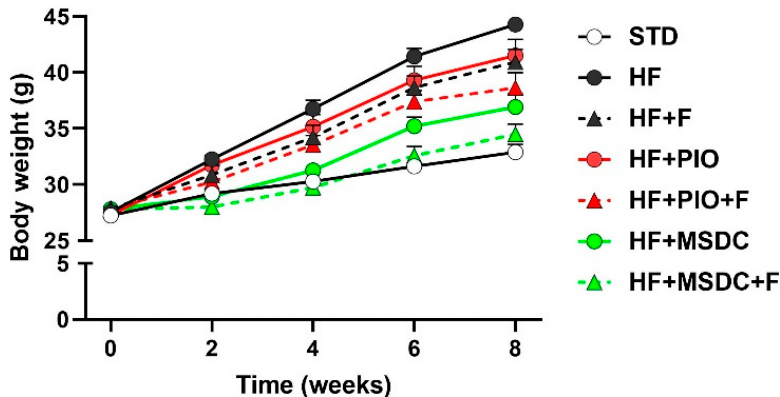
Figure 1. Body weights during dietary interventions. At 3 months of age, subgroups of mice ( n = 8–10) were fed STD or various high fat (HF) diets for 8 weeks. Data were pooled from two separate experiments (resulting in n = 16–19 / group). Data are means ± SEMs. For statistical di ff erences at week 8, see Table 2. For designation of dietary groups, see Section 2.1. STD: standard chow diet; HF: high-fat; PIO: pioglitazone. Table 2. Body mass, tissue weights, tissue TAG content and plasma parameters in mice fed various diets.